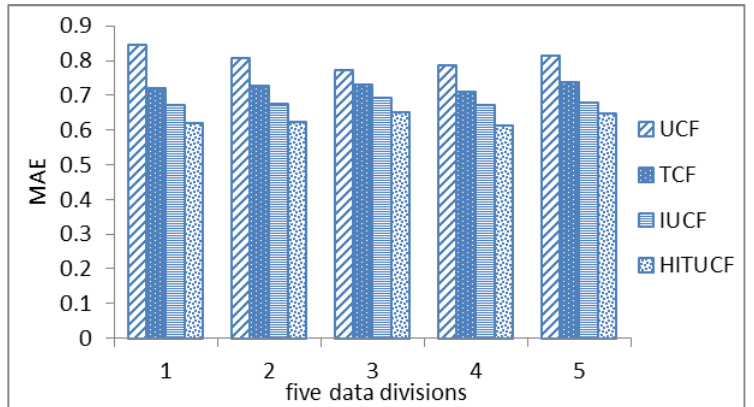
Figure 13. MAE of five data divisions.